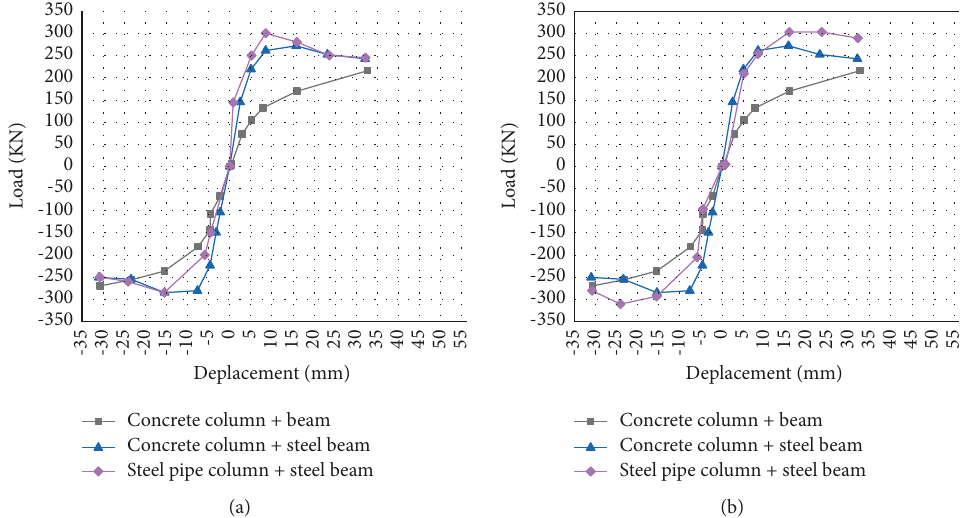
Figure 8: Simulation results of the ultimate bearing capacity of the steel beam joint: (a) bolt-type combination; (b) external diaphragm-type combination).